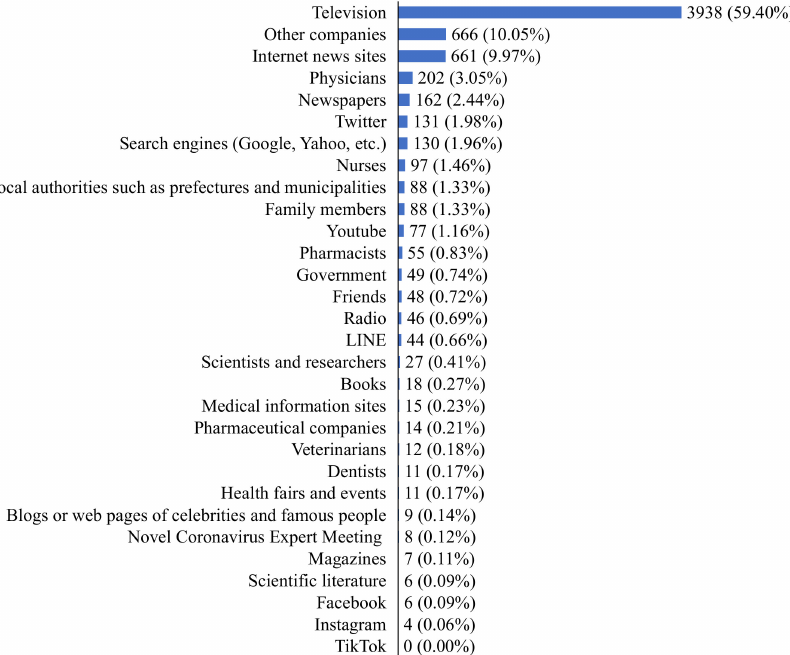
Figure 3. Type of information source used for those who only use one information source ( n =